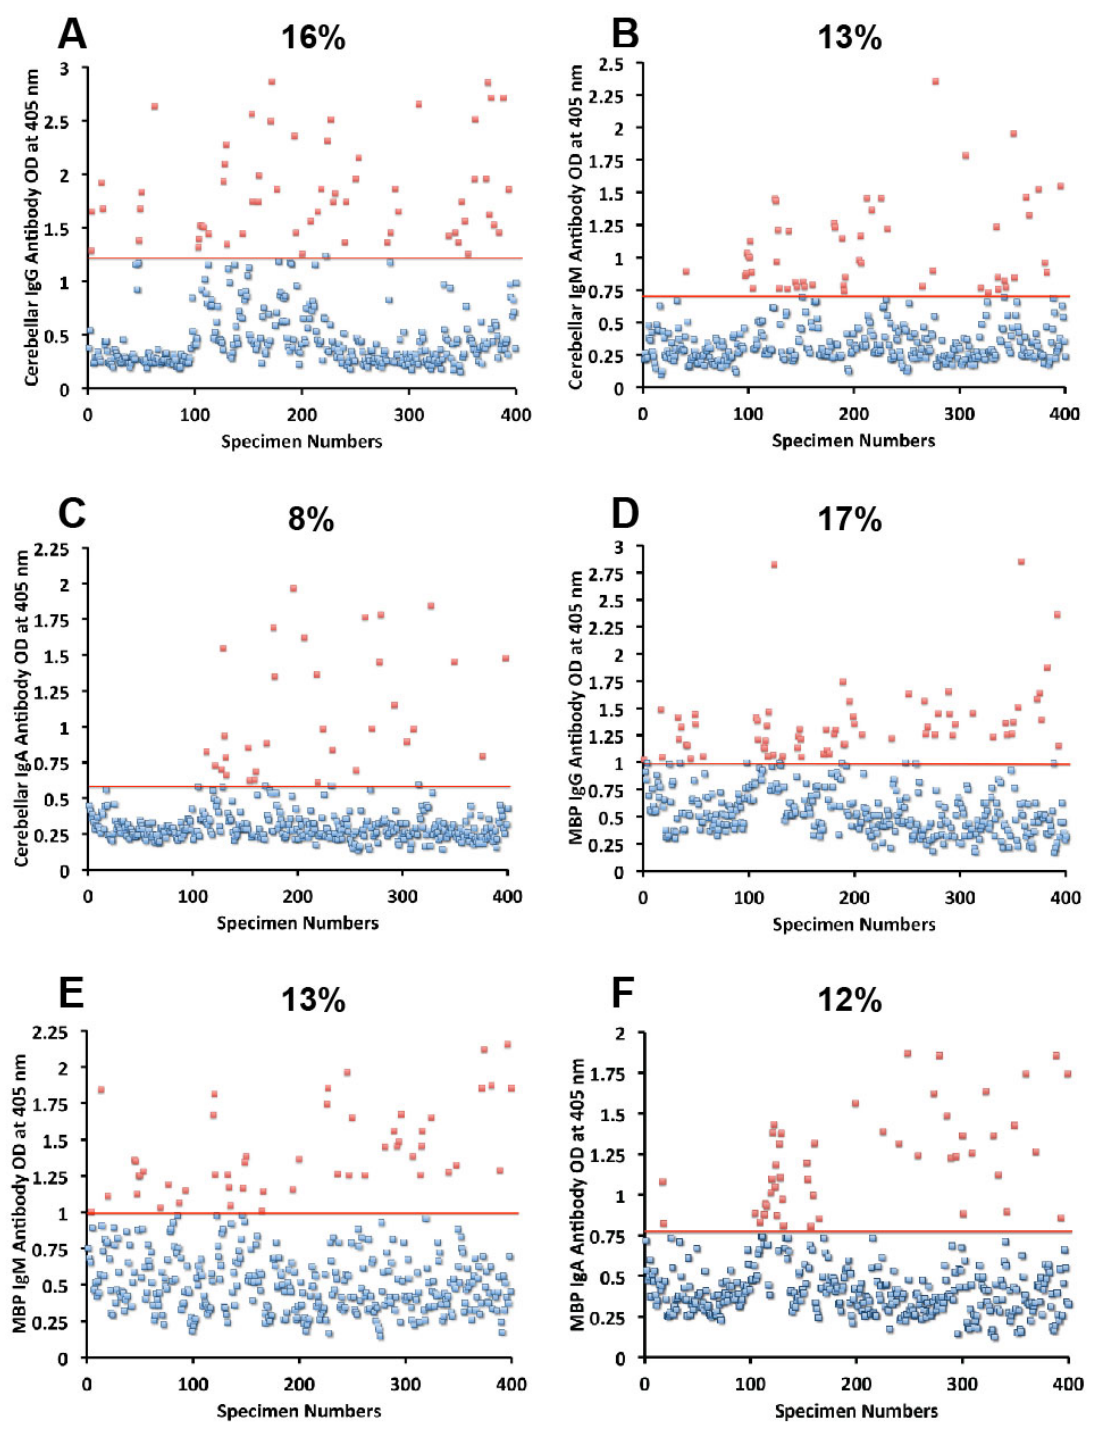
Figure 3. Results for cerebellar and MBP expressed as OD at 405 nm in the form of scattergrams with percentages of elevation. ( A ) Cerebellar IgG; ( B ) Cerebellar IgM; ( C ) Cerebellar IgA; ( D ) MBP IgG; ( E ) MBP IgM; ( F ) MBP